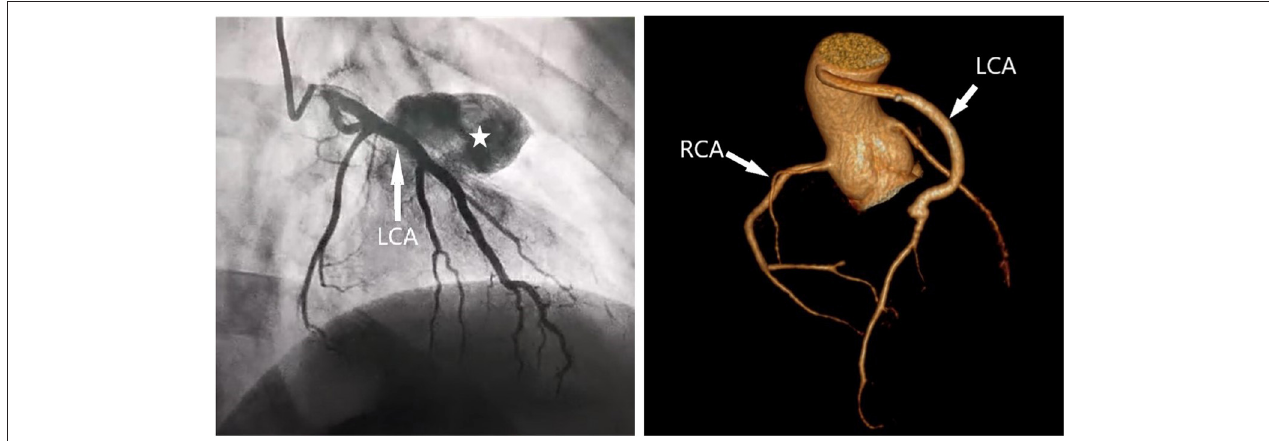
× 1.7 cm ( Figure 2A ). This result led us to the possibility